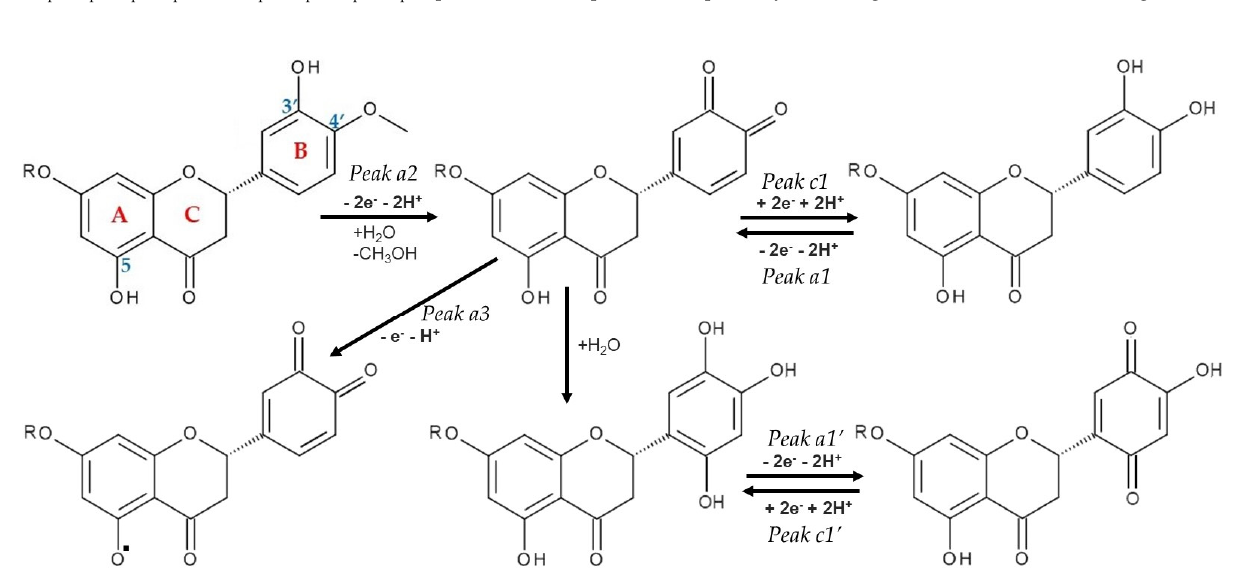
Figure 6. Proposed mechanism for HESP voltammetric behavior at H type PGE in BRB solution pH 1.81 [16,21].